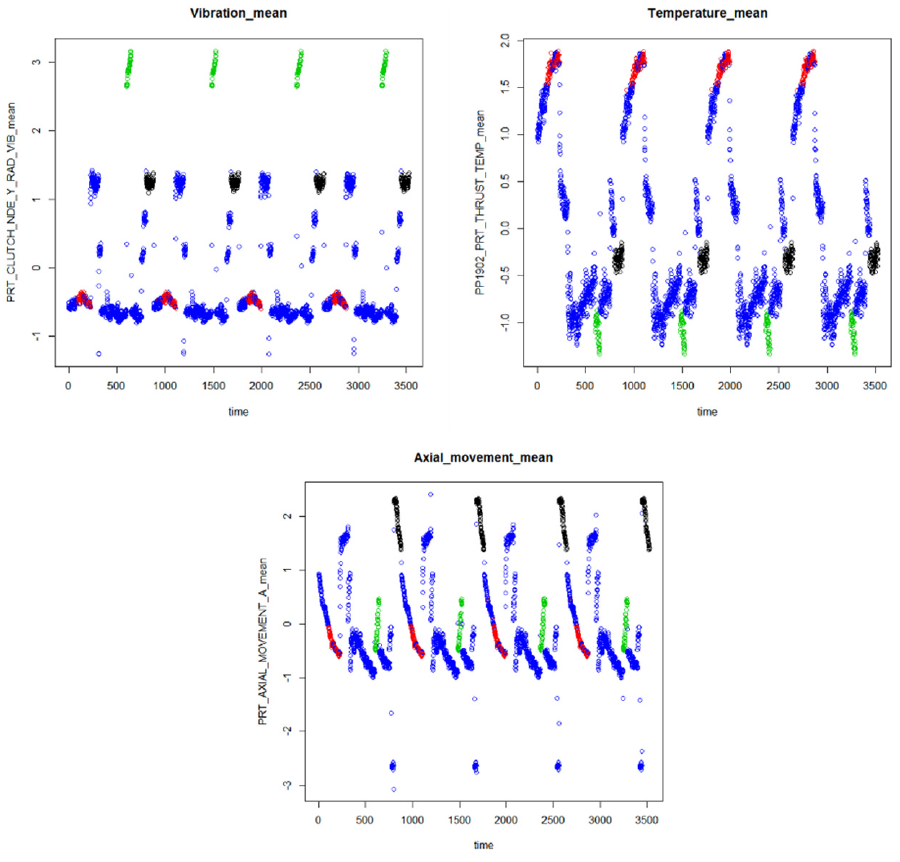
Figure 10. Scatter diagrams of equipment state.